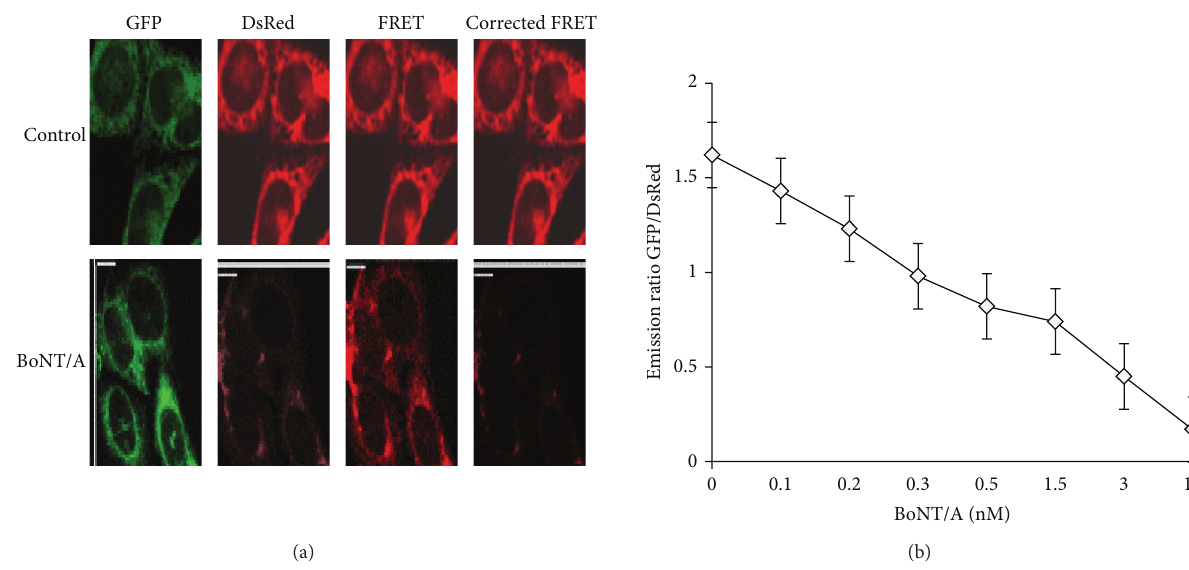
Figure 3: (a) Measuring toxin sensor in living cells. The stable clone 5A3 expressing the AcGFP-SNAP-25-DsRED sensor was treated with 10nM BoNT/A holotoxin, and the FRET signals of 100 cells were analyzed after 72 hours. (as described in Materials and Methods). Control cells not treated with toxins were analyzed in parallel (upper panel). Images of representative cells are shown. This sensor yielded significant FRET (upper “corrected FRET”), which was abolished after cells were treated with BoNT/A (72h, lower “corrected FRET”). Three images (GFP, FRET, and DsRED) were taken for each set of cells sequentially, using exactly the same settings. FRET signal was measured by exciting AcGFP and detecting DsRED signal. (b) Measurements of C-terminal reporter fragment degradation in clone 5A3 using a microplate reader (BioTek). The GFP and DsRED emissions were collected by fluorescence microplate reader (BioTek). Emissions were plotted as a function of BoNT/A at 0.03, 0.05, 0.15, 0.3, 1.5, 3.0, and 10nM concentrations. Data are presented as means ± SD ( 𝑛 = 3 ).